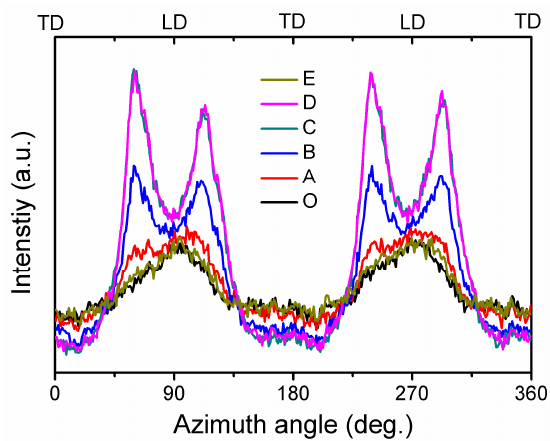
Figure 8. Intensity distributions of the (021) α ” diffraction peaks along the azimuth angle at different applied strains corresponding to points O–E in Figure 3b.